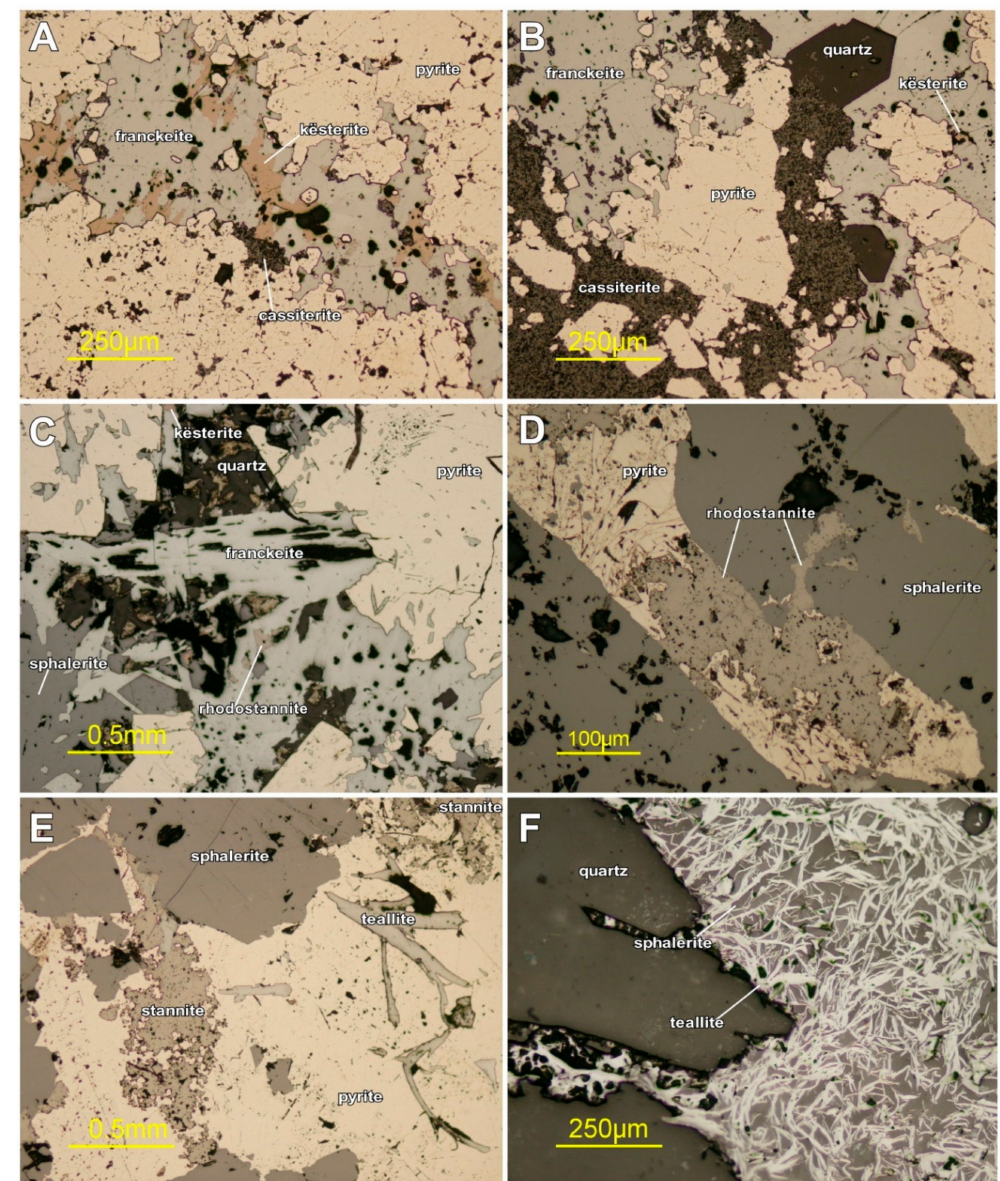
Figure 6. Polarised reflected light images of ore associations that are rich in tin minerals at the Poop ó deposit. ( A , B ) Pyrite reactively followed by cassiterite (“needle tin”), passively followed by quartz, reactively followed by franckeite and these, in turn, by kësterite. ( C ) Pyrite reactively followed by franckeite + sphalerite, reactively followed by rhodostannite and kësterite. ( D ) Pyrite reactively followed by sphalerite, and reactively followed by rhodostannite. ( E ) Sphalerite reactively followed by pyrite, and by stannite + teallite. ( F ) Close association between sphalerite and